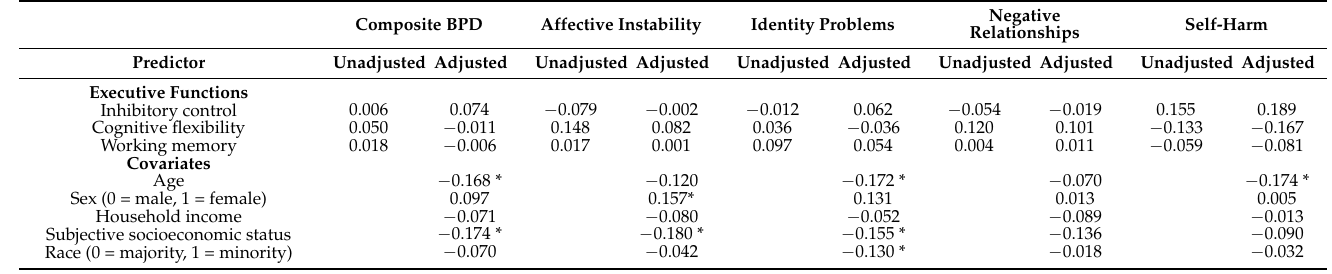
Table 3. Standardised coefficient estimates of three latent variables of inhibitory control, cognitive flexibility, and updating-working memory capacity predicting composite BPD and four subfactors of affective instability, identity problems, negative relationships, and self-harm.